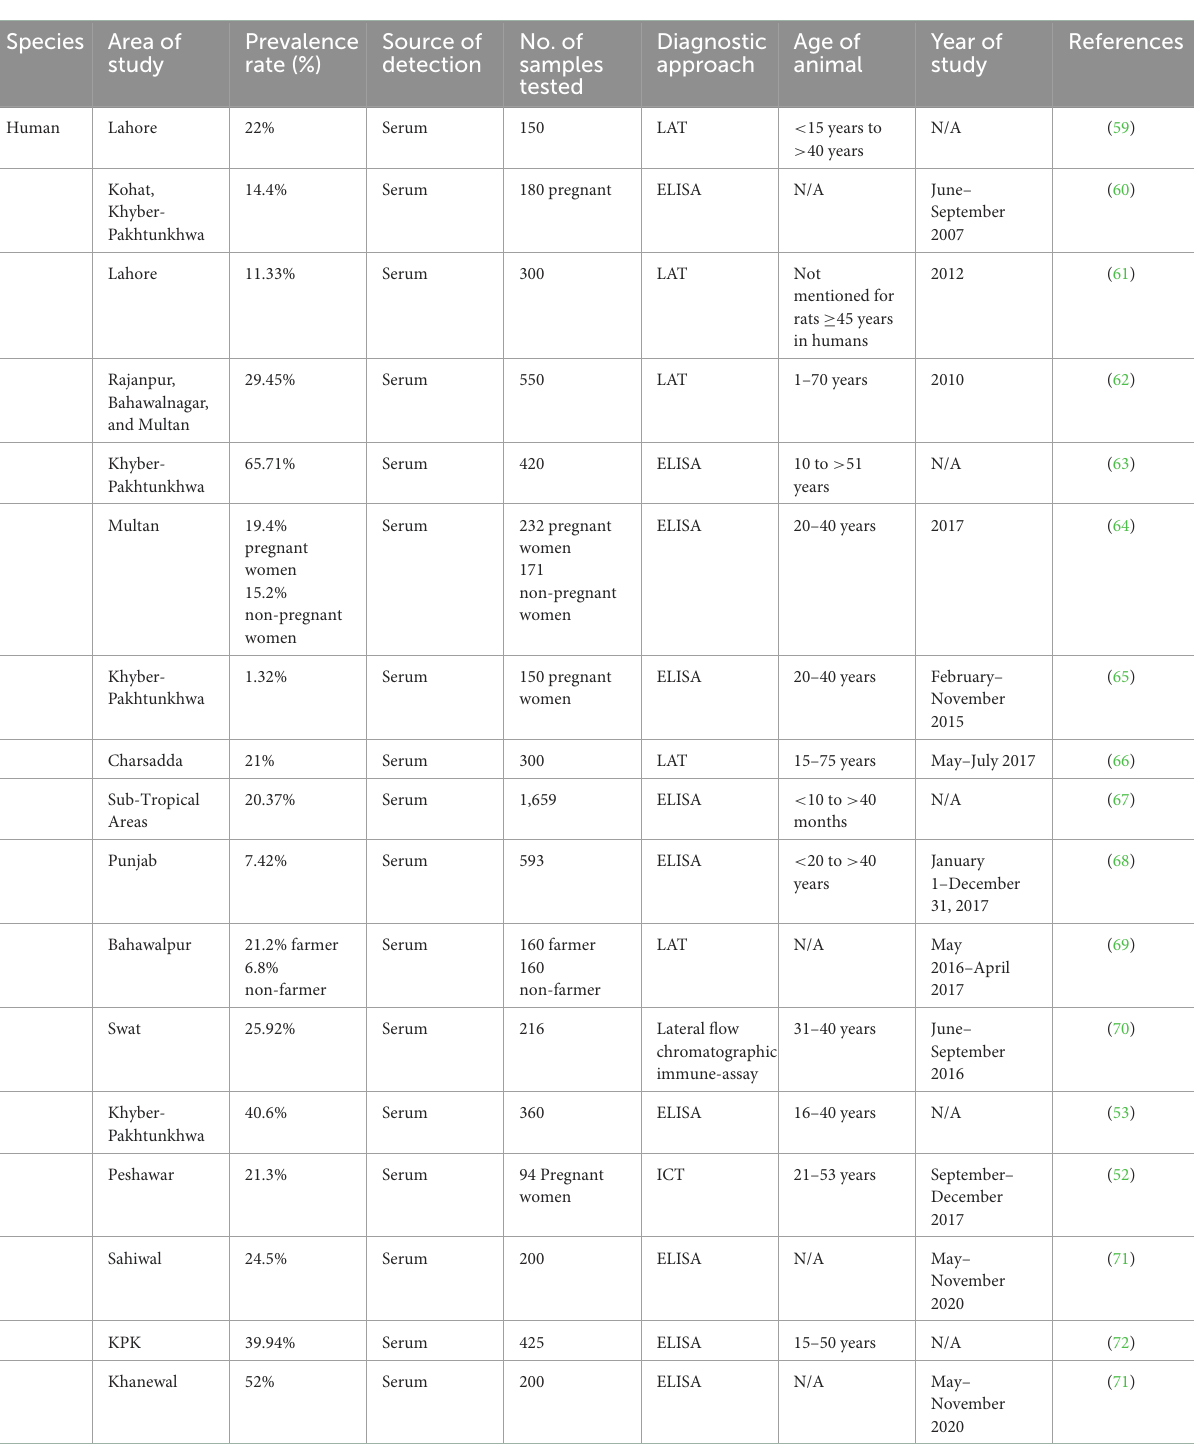
TABLE 1 Reported prevalence of Toxoplasma gondii in human population of Pakistan. Species Area of